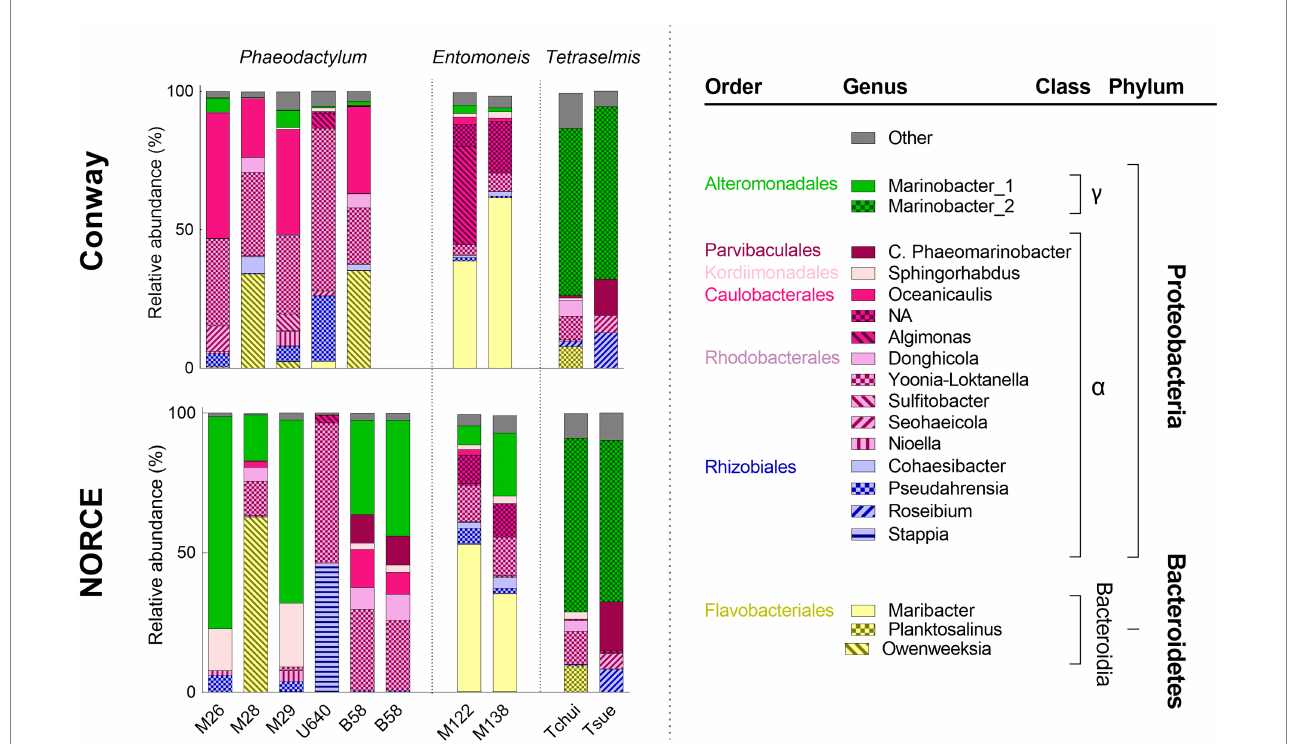
FIGURE 4 Bacterial community composition for stock cultures of nine microalgal strains in Conway and NORCE medium. Genera with an abundance higher than 5% of total bacterial abundance are shown, bacteria with lower abundance are summarized in